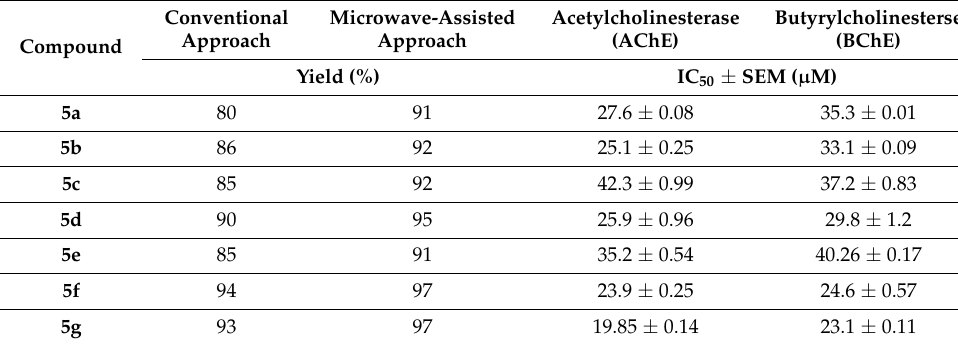
Table 1. Comparative synthetic yields and anti-cholinesterase (AChE and BChE) potential of syn- thesized compounds 5(a – m) and 6(a – m) .